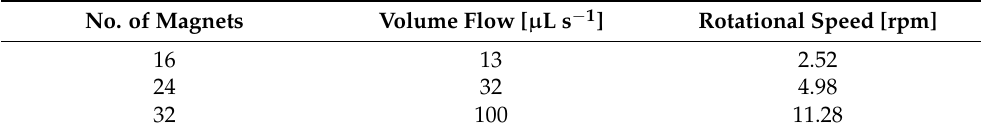
Table 2. Maximum flow rates for the three